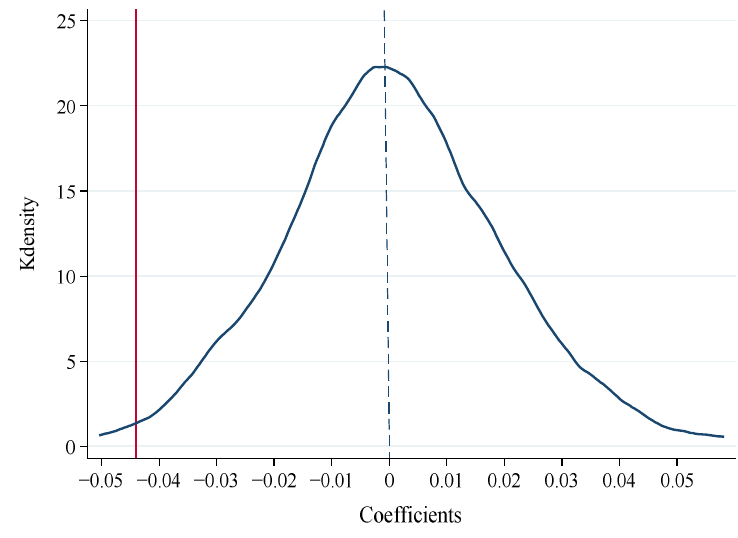
Figure 3. Kernel density distribution of treatment effect for 500 times.